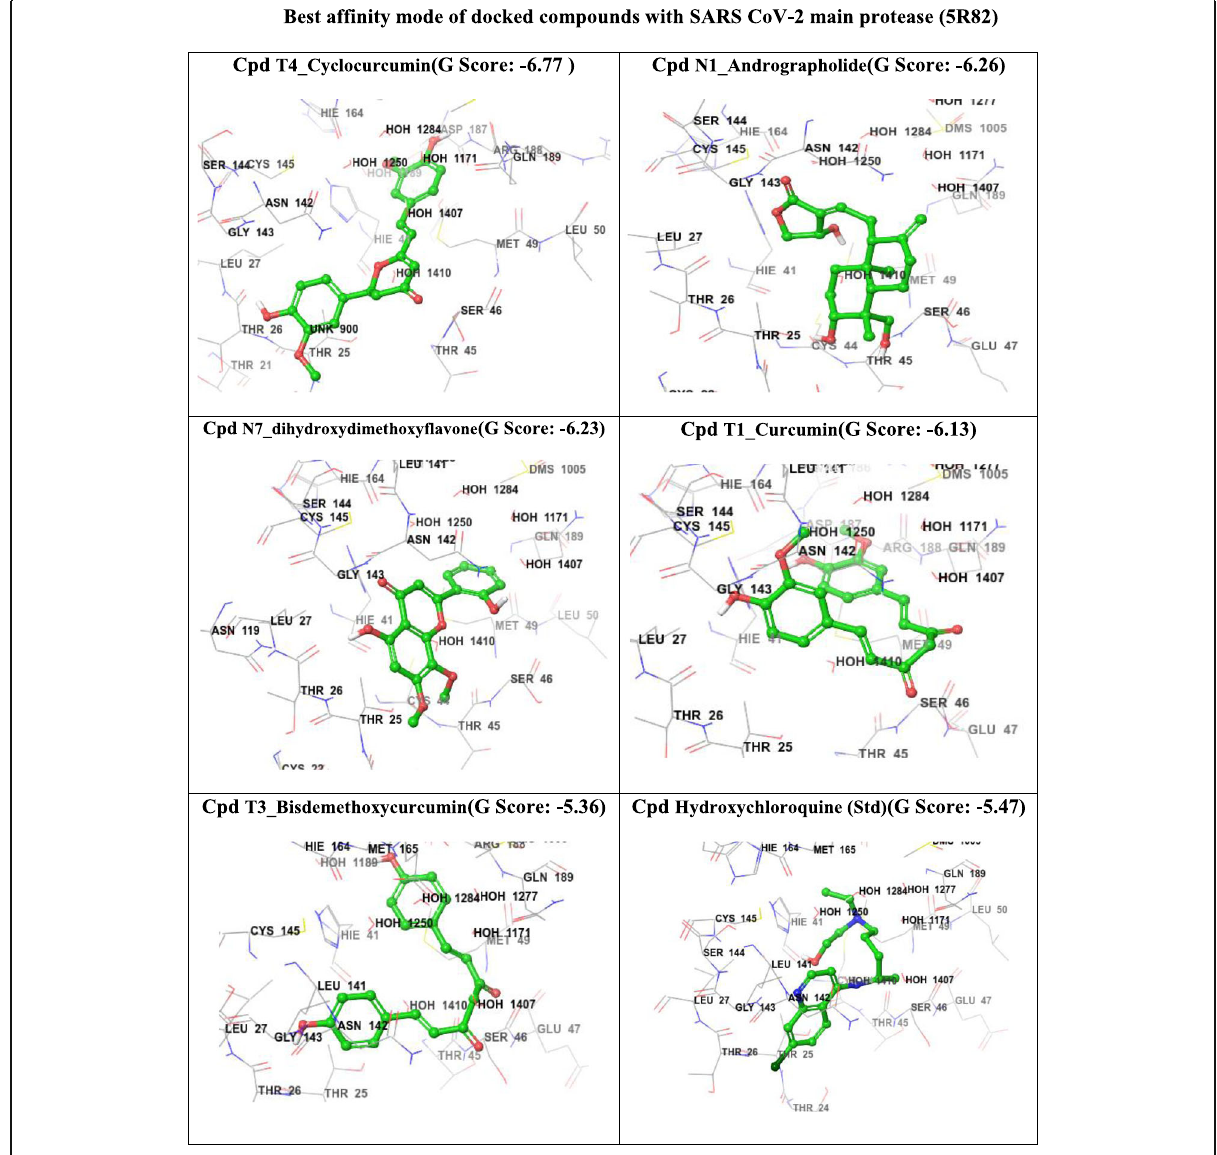
Fig. 4 Best affinity mode of docked compounds with SARS CoV-2 main protease